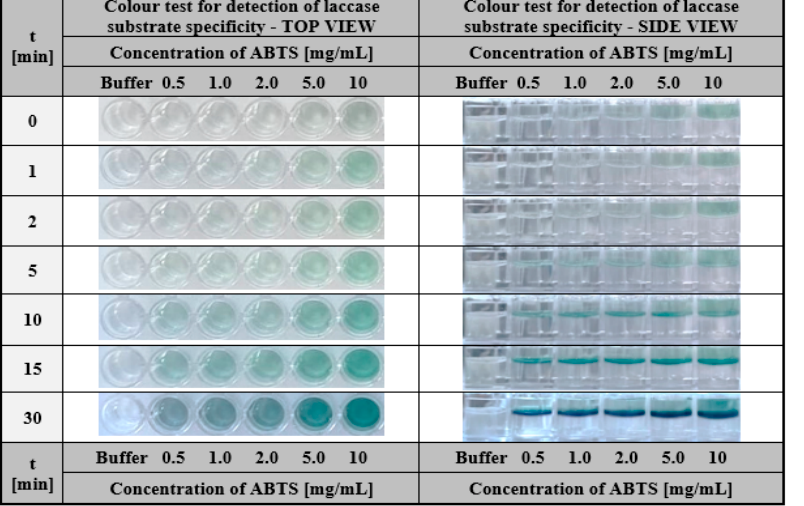
Figure 10. The visual response obtained after a different time of hydrogel-based test with immobilised laccase from Trametes versicolor (final concentration 200 µ g/mL) was performed for ABTS solutions with a concentration in the range of 0.5–10 mg/mL.